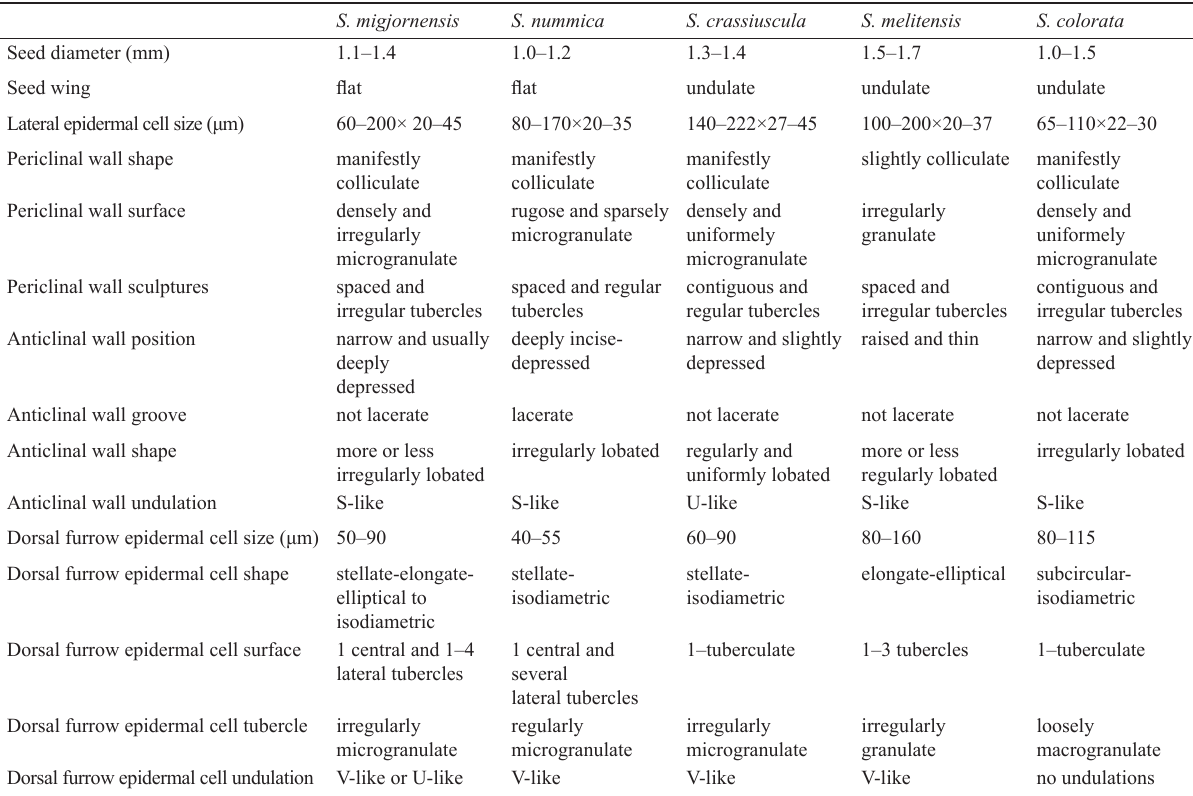
Table 2. Comparison among seed features of Silene migjornensis and most closely related species belonging to sect. Dipterosperma , based on our own results and Brullo et al.